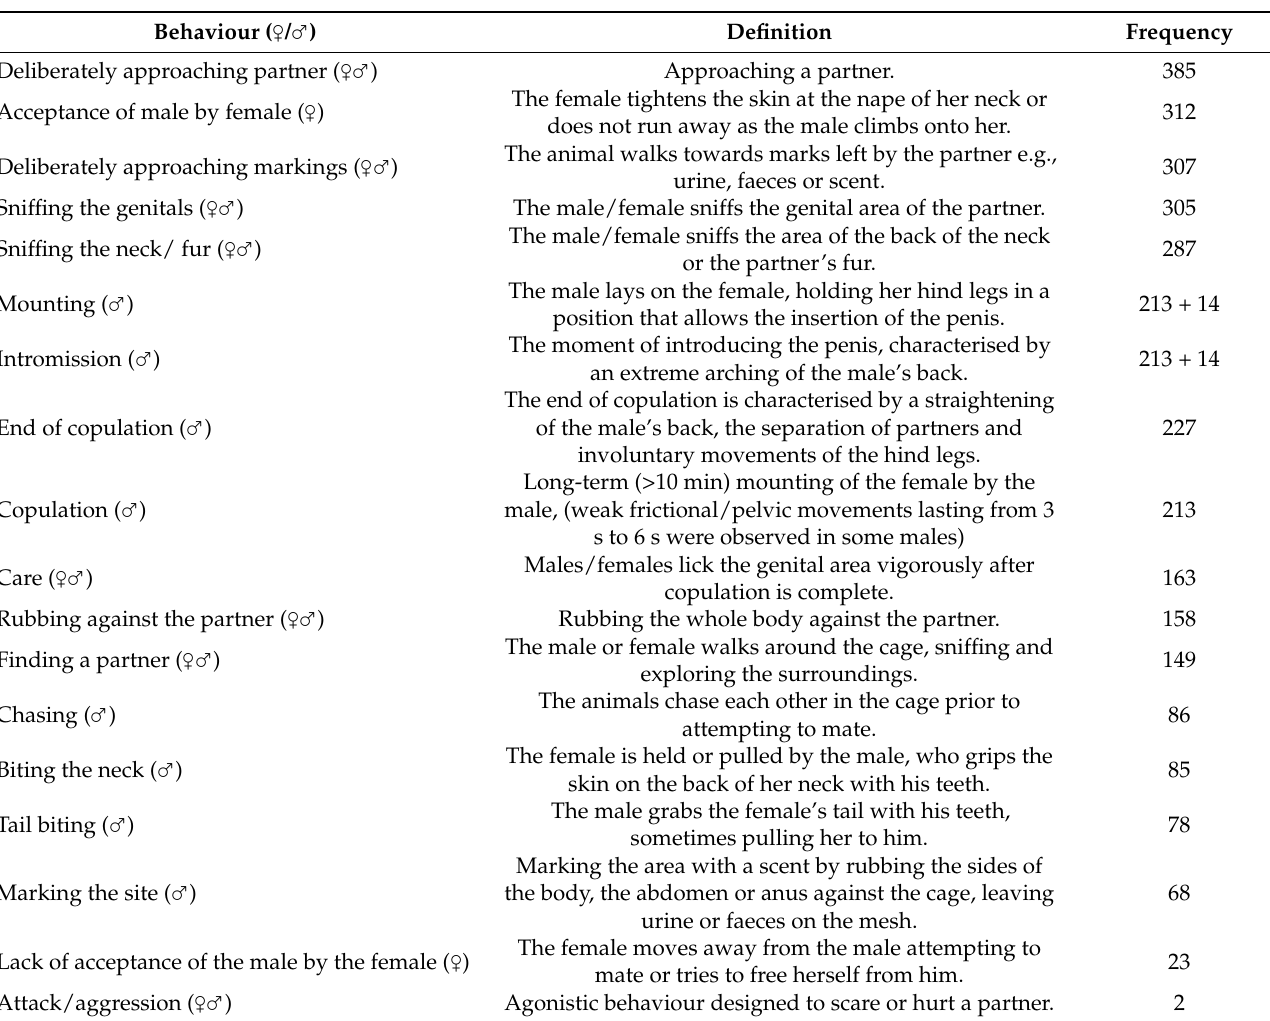
Table 1. Ethogram of American mink reproductive behaviour in farmed conditions